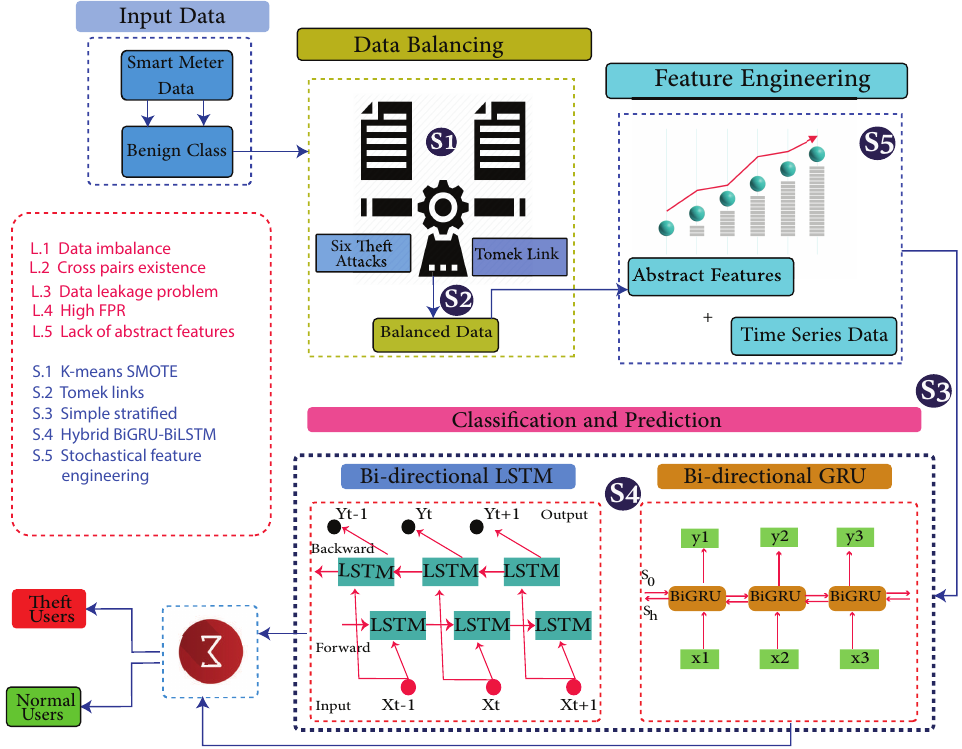
Figure 1. System Model Architecture. Table 1. Mapping of Limitations and Proposed Solutions.